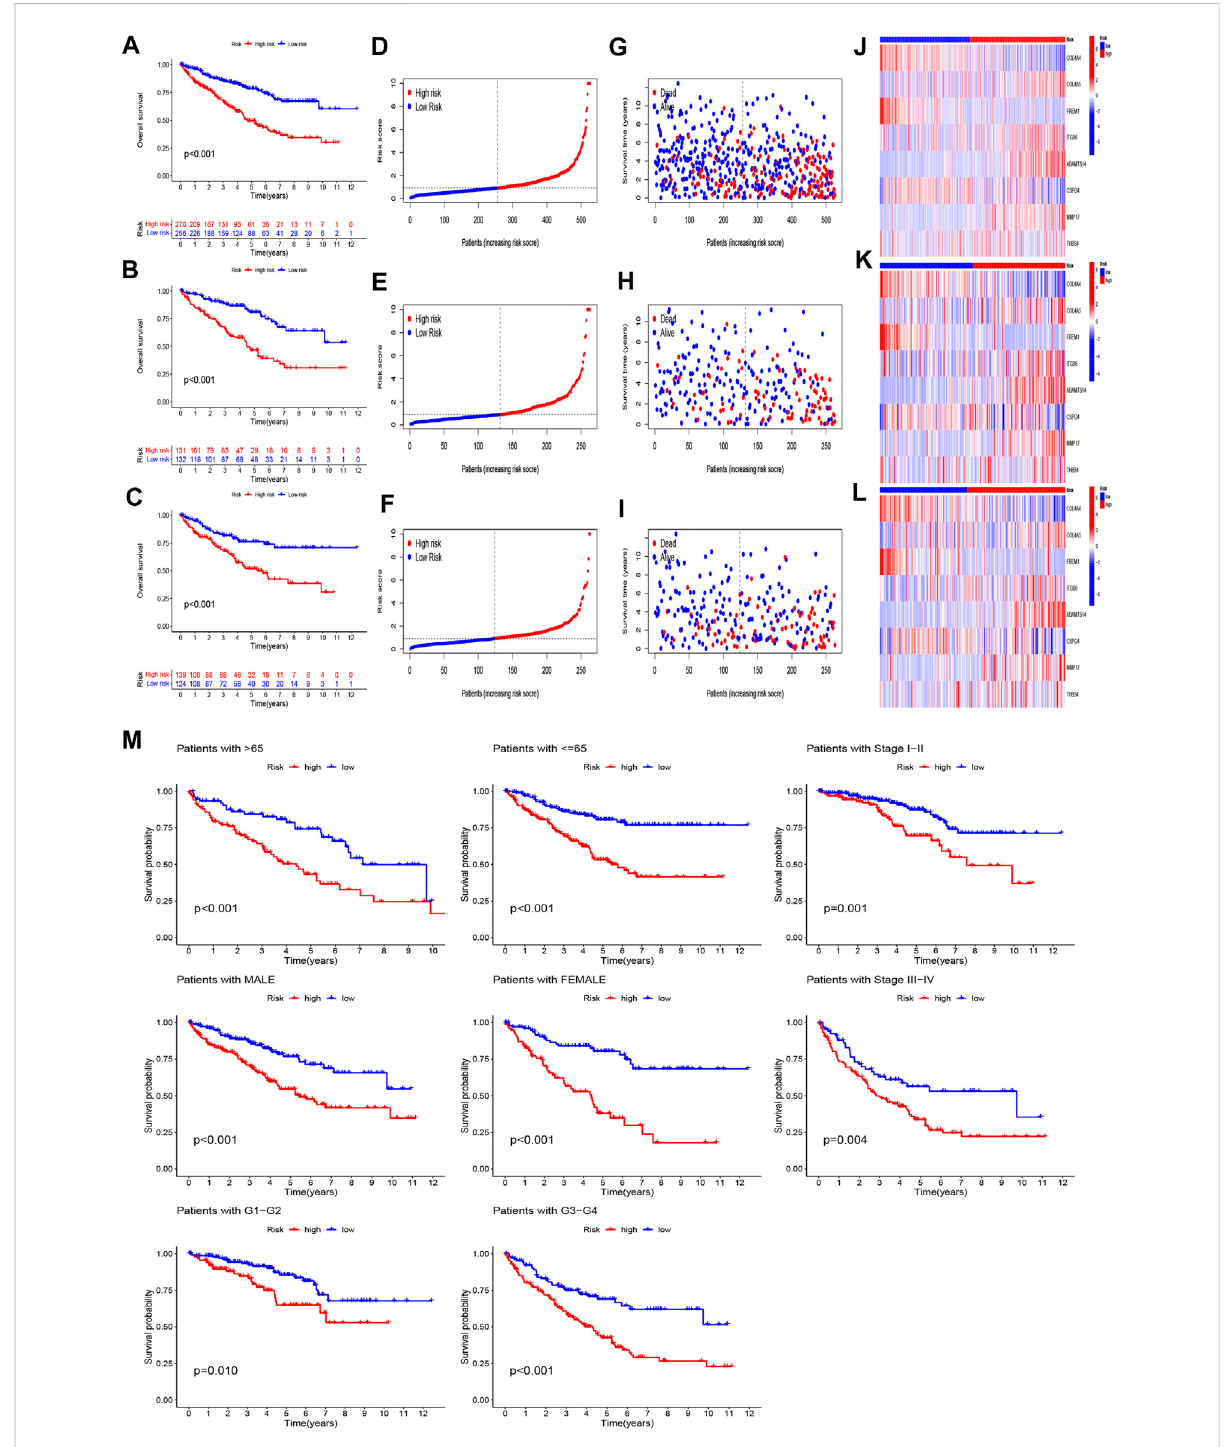
FIGURE 4 Prognosis value of the eight-BMRG model in the full, training, and test sets. (A – C) Survival curves of patients comparing the two groups in the full, training, and test sets, respectively. (D – F) Distribution of the BMRG model according to the risk score of the full, training, and test sets, respectively. (G – I) Survival status and time of patients between the two groups in the full, training, and test sets, respectively. (J – L) Heatmap of the eight BMRGs from the two groups in the full, training, and test sets, respectively. (M) Survival curves strati fi ed by age, gender, grade, and stage between the two groups in the full